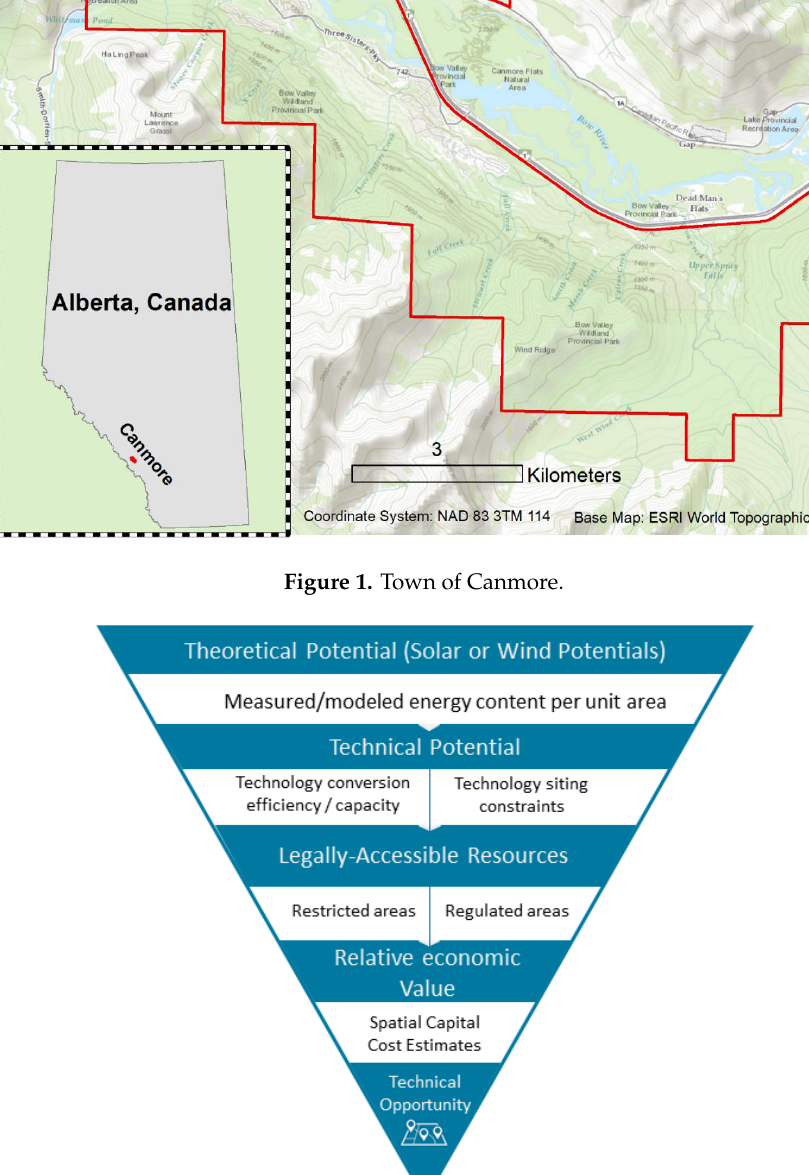
Figure 2. Framework used in this study to conduct detailed technical mapping for local energy planning. Modified from Calvert